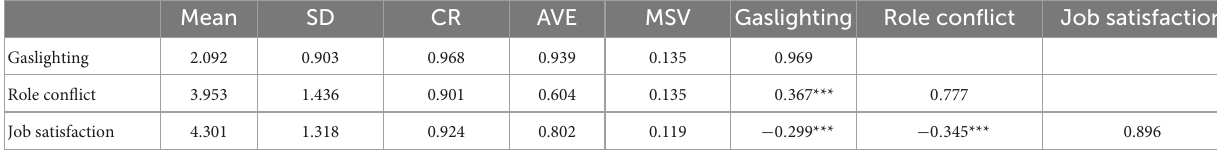
TABLE 5 Descriptive statistics and validity analysis.